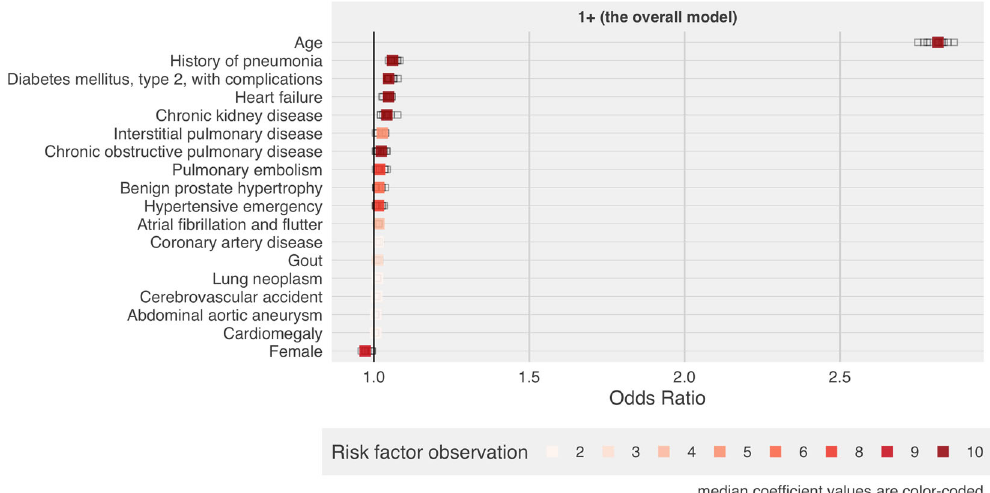
Fig. 3 Odds ratios for the covariates identi fi ed as predictors of mortality in COVID-19 patients. Risk factor observation represents the number of model iterations that identi fi ed a covariate as a predictor of mortality in COVID-19 patients. The total number of model iterations is 10. Median and interquartile ranges (IQR) for odds ratios are available in Supplementary Table